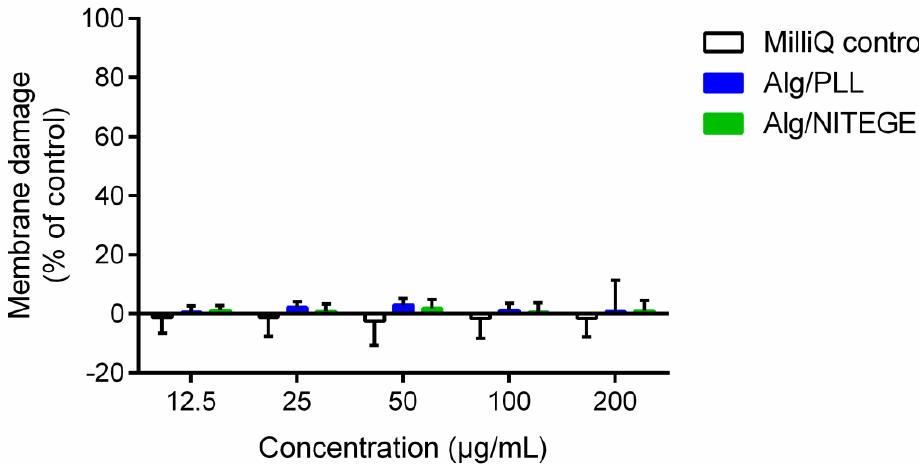
Figure 8. Membrane damage of HGFIB in response to Alg/PLL and Alg/NITEGE nanoparticle suspensions after 24 h. Alg/PLL and Alg/NITEGE nanoparticles and MilliQ water as control were diluted in DMEM with 5% FCS. Untreated cells were set to 0% of membrane damage. Mean and standard deviation of three independent experiments are shown.